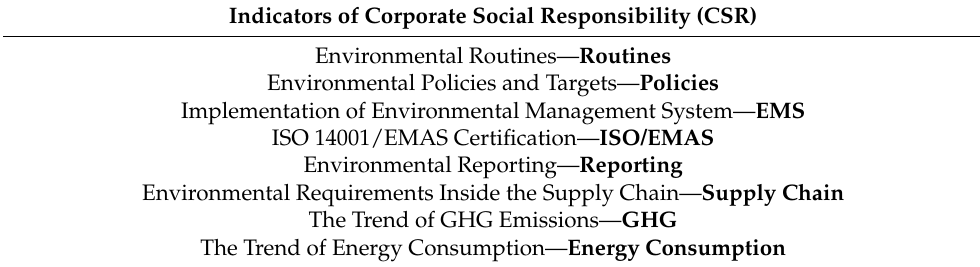
Table 1. Indicators of CSR used in research.